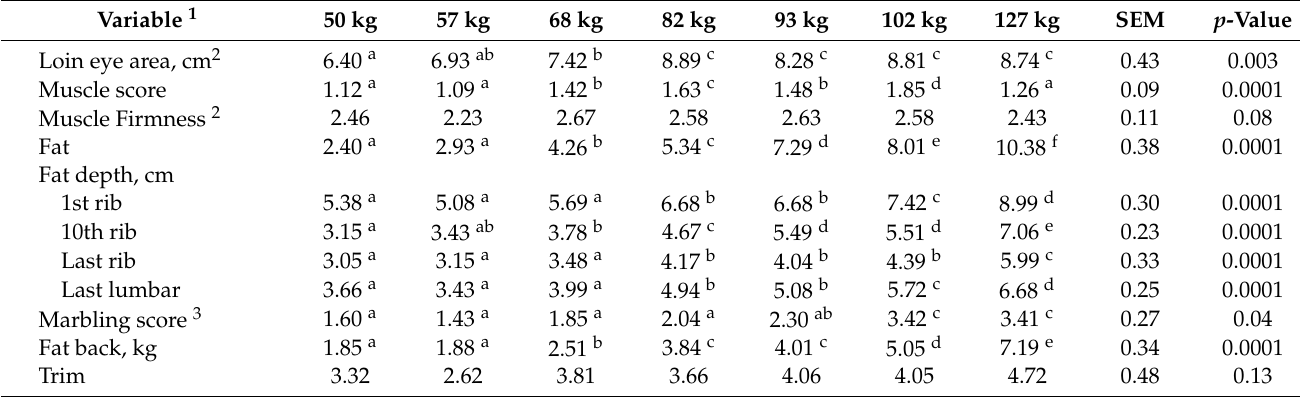
Table 4. Carcass composition of Mangalica pigs at different weight